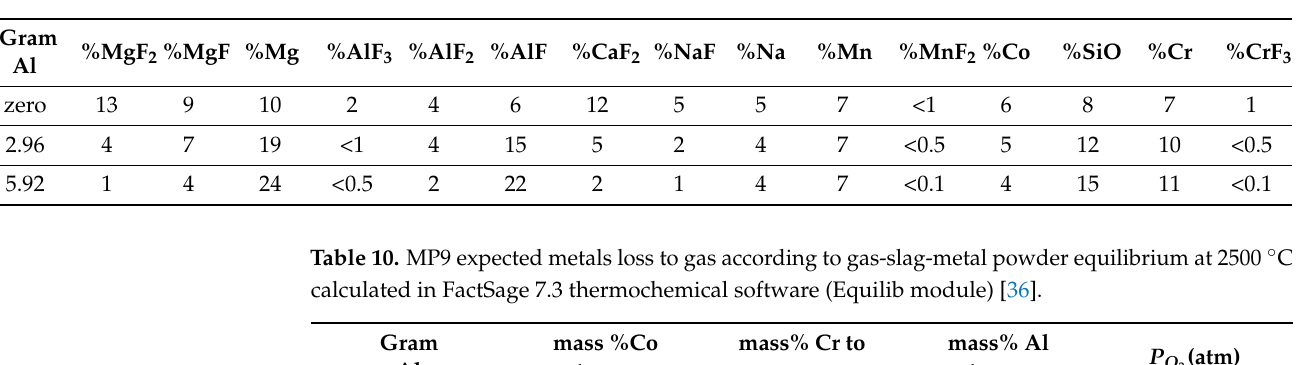
Table 9. MP9 gas composition (volume %) output from gas-slag-metal powder equilibrium at 2500 ◦ C